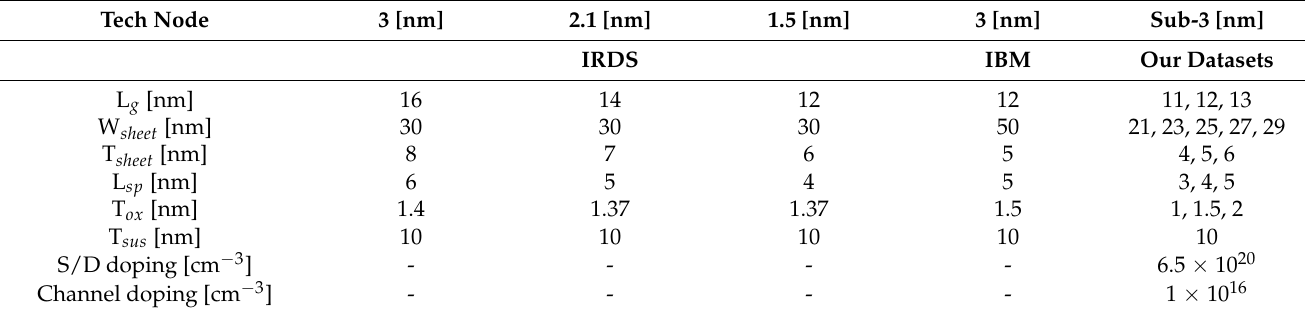
Table 2. Key parameters of NSFETs for the TCAD